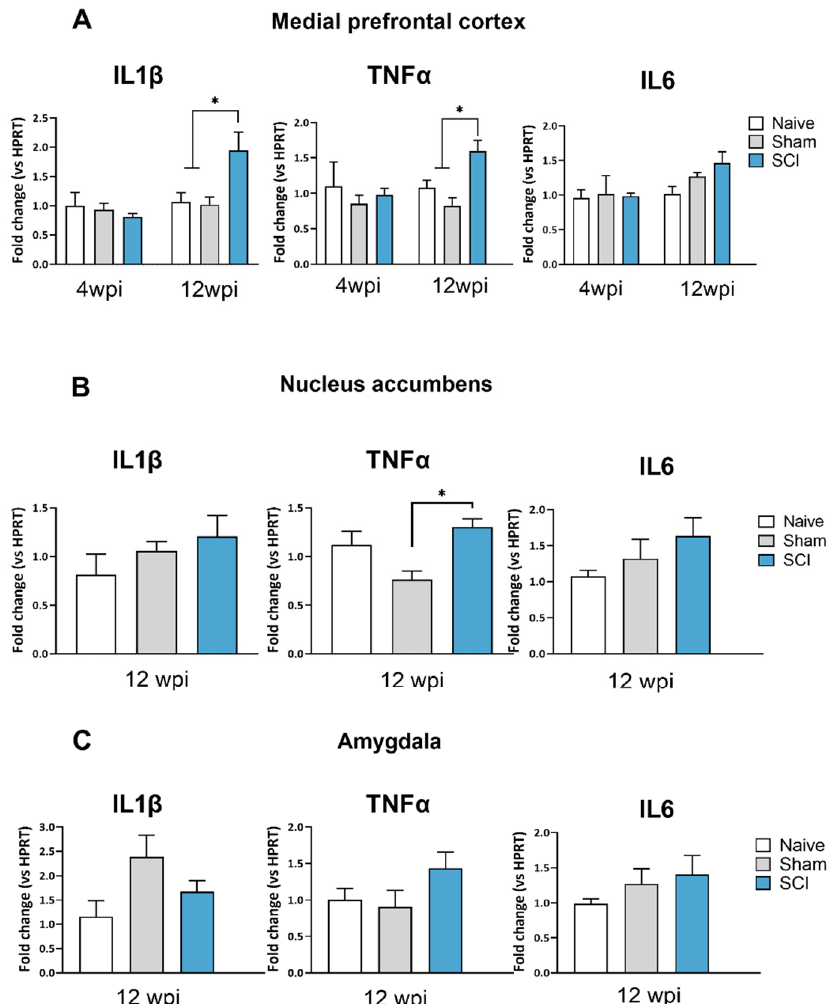
Figure 6. Supraspinal cytokines expression after mild spinal cord injury (SCI). SCI mice showed an increase of IL1 β and TNF α in the medial prefrontal cortex ( A ) at 12 wpi, an increase in TNF α in nucleus accumbens ( B ) at 12 wpi and no cytokine expression changes in the amygdala ( C ). The results are the mean ± SEM. Experimental groups: Naive (n = 4–6), Sham (n = 5–6) and SCI (n = 5–6). * p < 0.05 (one-way ANOVA followed by Tukey’s post-hoc test). IL1 β , Interleukin 1 β ; TNF α ; Tumor necrosis factor- α ; IL-6, Interleukin-6; SCI, spinal cord injury; wpi, weeks post